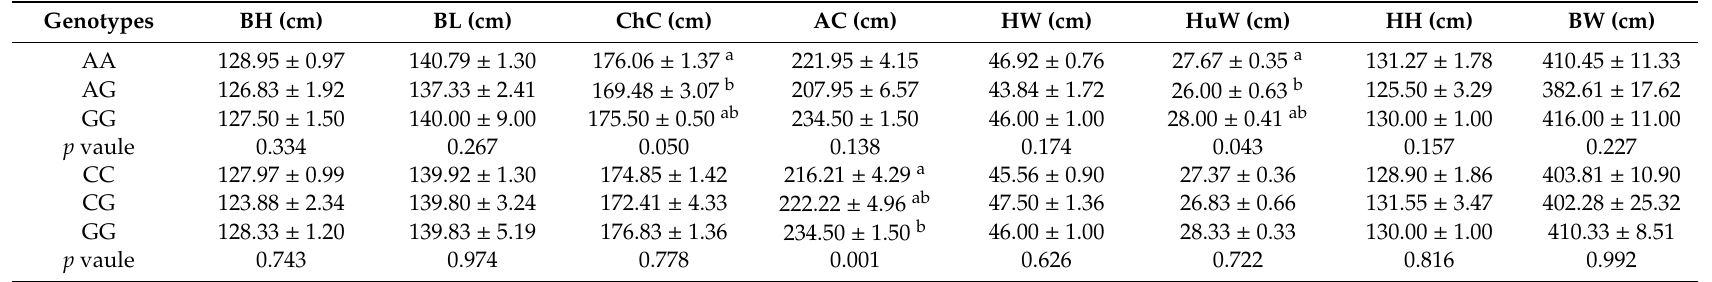
Table 5. Association analysis of single SNP in RET with body measurement in Nanyang